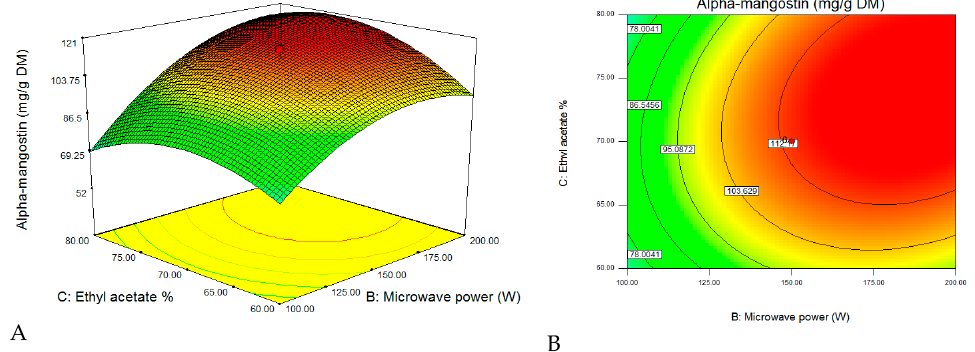
Figure 3. The response surface plots for the effects of microwave power (W) and ethyl acetate concentration (%) on the α -mangostin content of G. mangostana . ( A ) Three-dimensional (3D) view; ( B ) flat view.